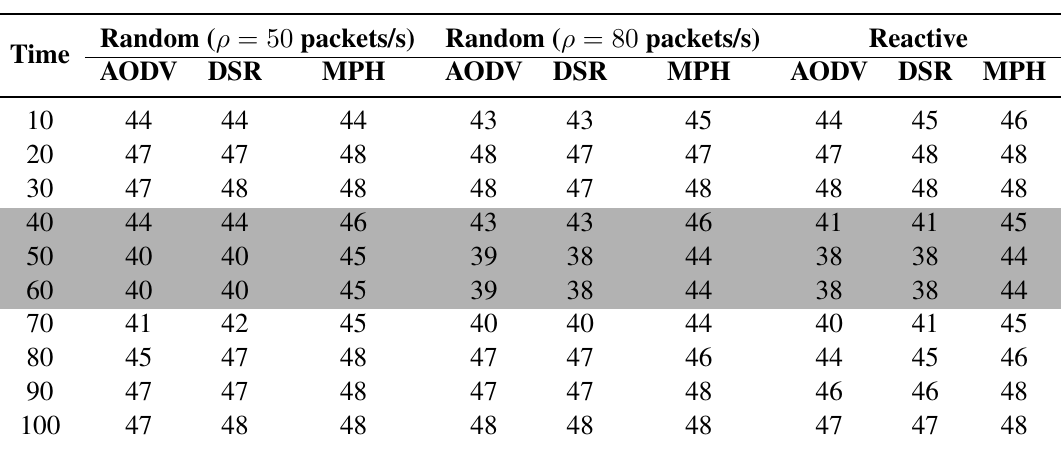
Table 6. Number of reached nodes by the coordinator when the jammer node is in the middle of the topology.